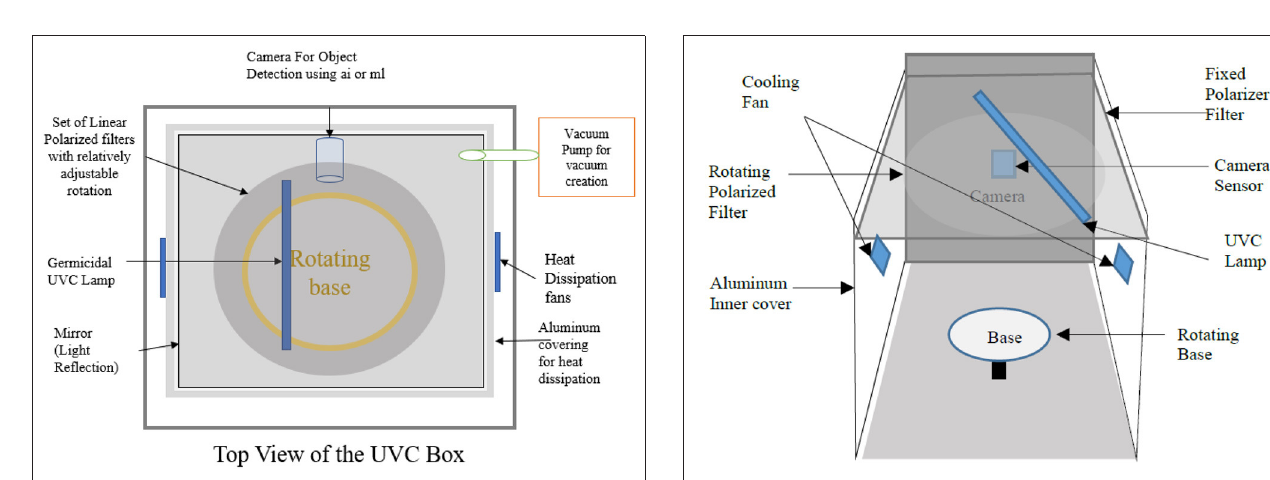
FIGURE 2 | Front view of the UVC device.